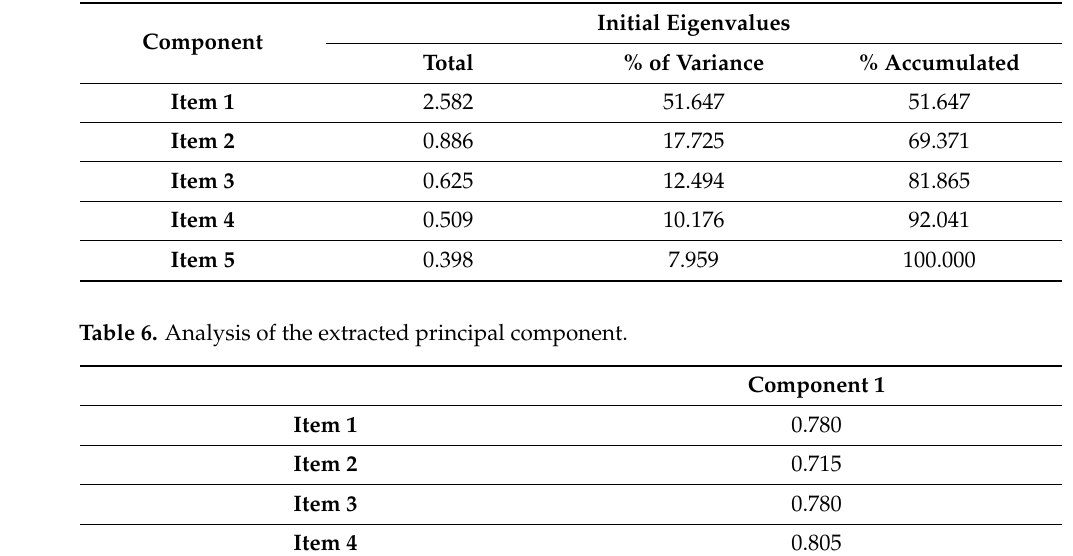
Table 5. Principal component extraction method.